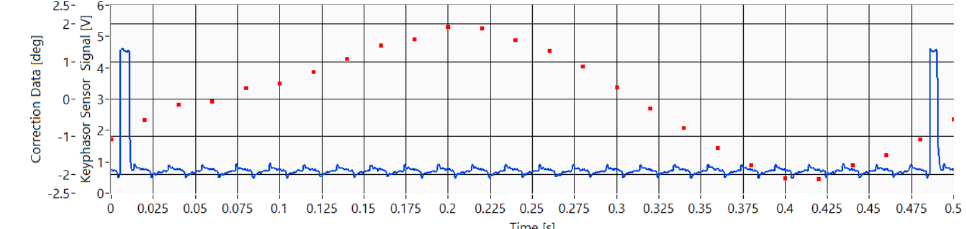
Figure 14. Results of determining the correction data in relation to the keyphasor sensor signal obtained in the algorithm testing. The red dots represent the correction data values.